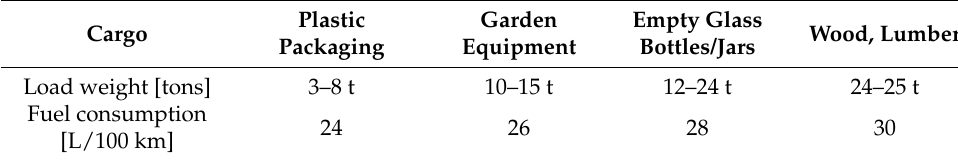
Table 5. Fuel consumption depending on load weight (example–company 1).